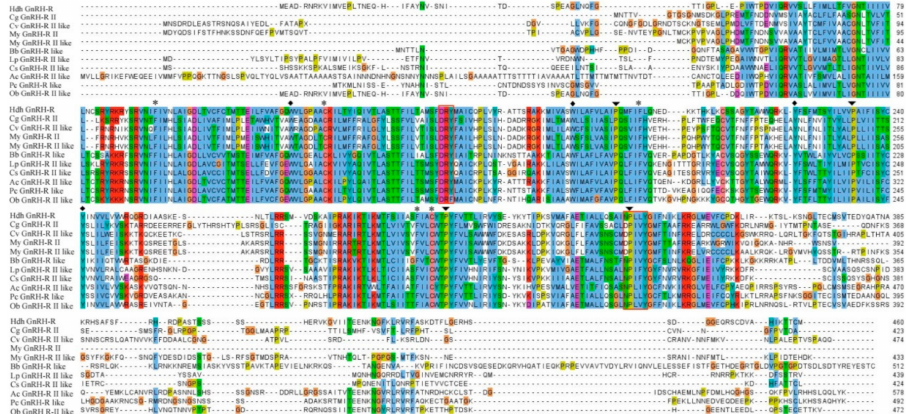
Figure 2. Multiple sequence alignment of HdhGnRH-R gene with representative invertebrates GnRH-R homologs. Conserved residues that might be involved in GnRH binding to the receptor are marked with asterisks. Conserved GPCRs activation residues are indicated by rectangular boxes. The conserved proline residues and tertiary structure formation residues are denoted by black arrowheads and diamond circles, respectively. Hdh- H. discus hannai (MN270936); Cg- C. gigas (EKC32751.1); Cv- C. virginica (XP_022304394.1); My- M. yessoensis (GnRH-R II: OWF54054.1; GnRH-R II